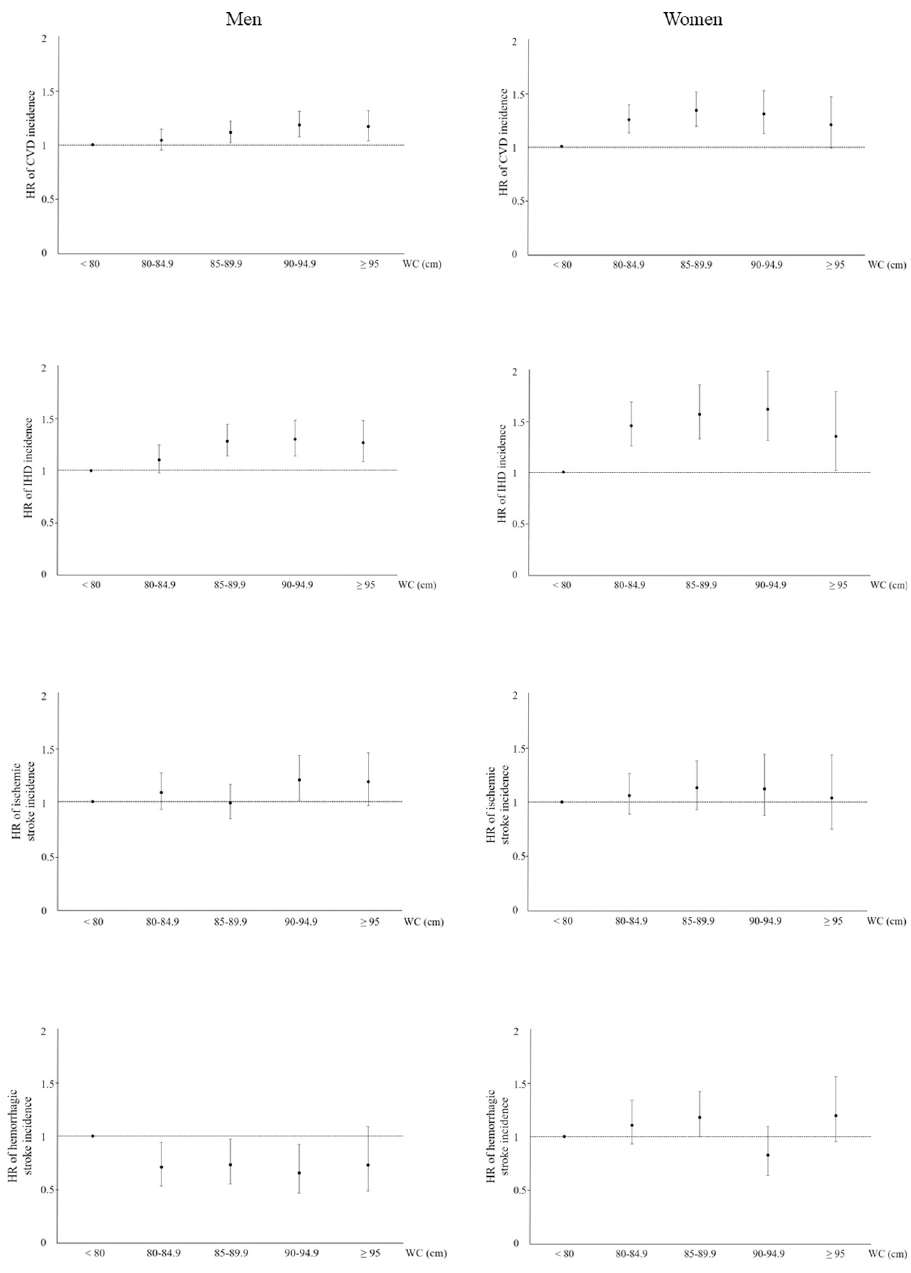
Fig 2. Cardiovascular disease incidence according to waist circumference categories. HRs were adjusted for age, smoking status, alcohol consumption status, level of physical activity, total cholesterol, hypertension, and diabetes mellitus status. WC, waist circumference; CVD, cardiovascular disease; HR, hazard ratio.